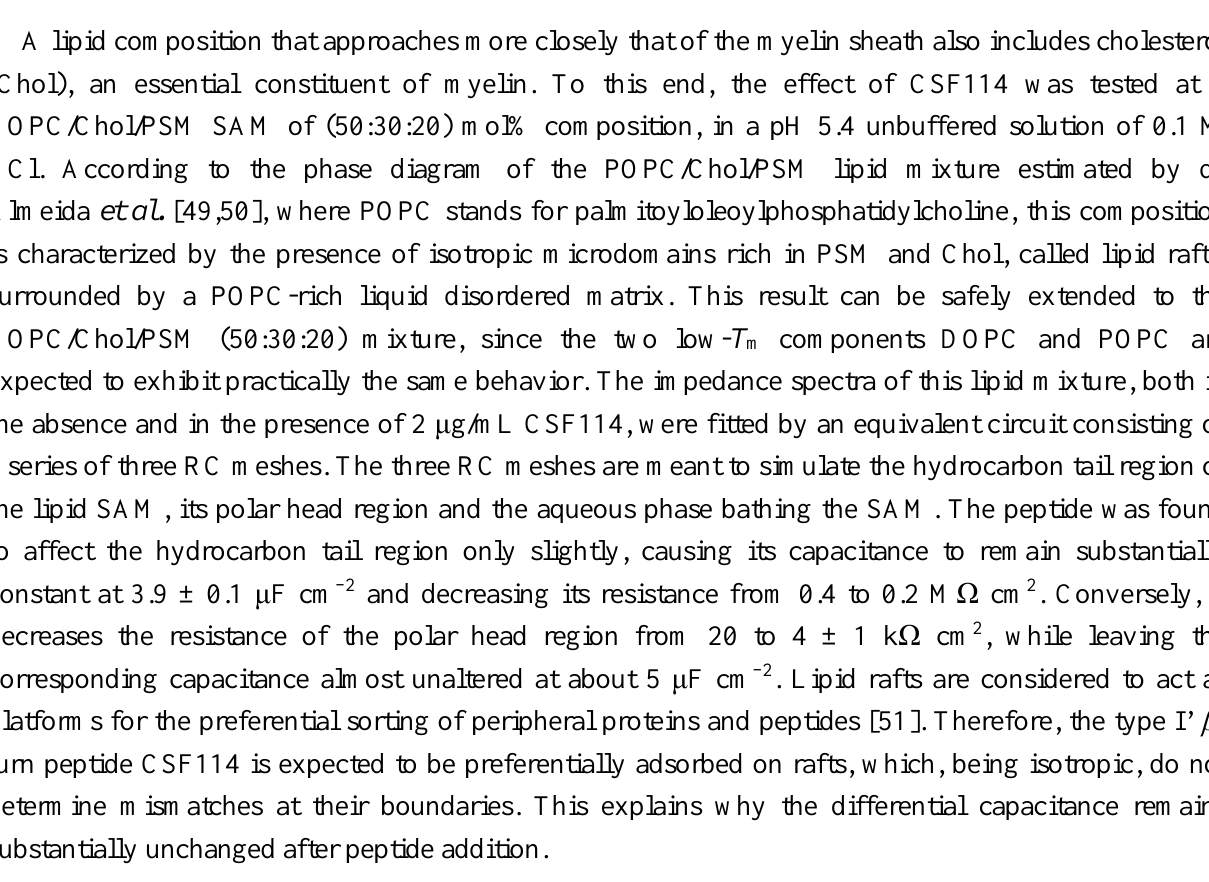
Figure 9. Cyclic voltammogram at a SAM of a DOPC/PSM (2:1) mol% lipid mixture in a pH 5.4 unbuffered solution of 0.1 M KCl and 4 × 10 −5 M CdSO 4 in the absence of CSF114 (dashed curve) and in the presence of 2 μg/mL CSF114 (solid curve). The dash-dotted curve is the cyclic voltammogram on bare mercury in unbuffered solution of 0.1 M KCl and 4 × 10 −5 M CdSO 4 . Scan rate = 0.05